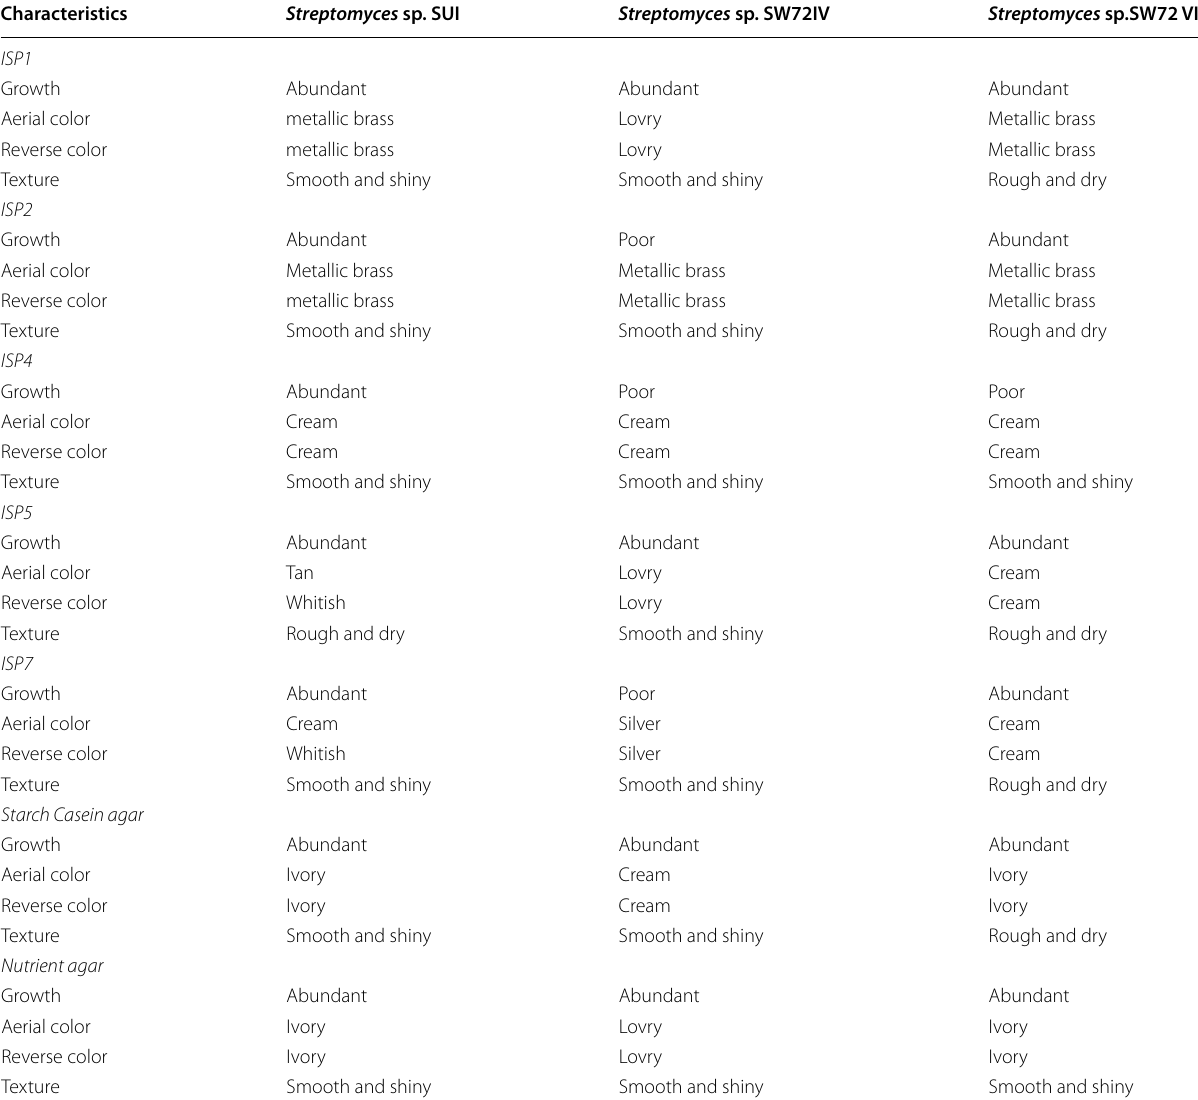
Table 1 Cultural characteristics of Streptomyces sp. SUI, Streptomyces sp. SW72IV and Streptomyces sp. SW72VII